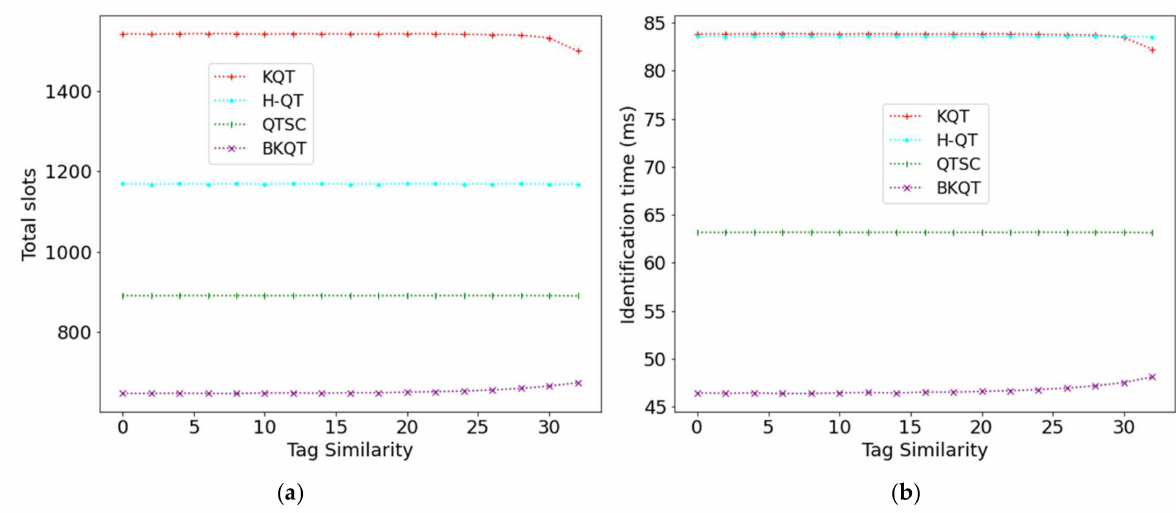
Figure 6. Total slots and identification time subject to tag similarity. ( a ) Total slots, ( b ) Identifica- tion